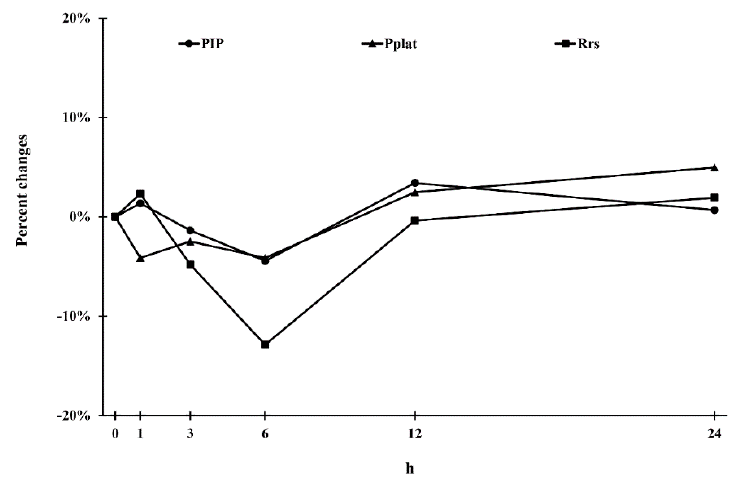
Figure 1. Percent changes ( △ -difference %) in Peak inspiratory pressure (PIP), mean airway pressure (Pmean), plateau pressure (Pplat), and maximum resistance of the respiratory system (Rrs). Table 2. Respiratory parameters from ventilator.